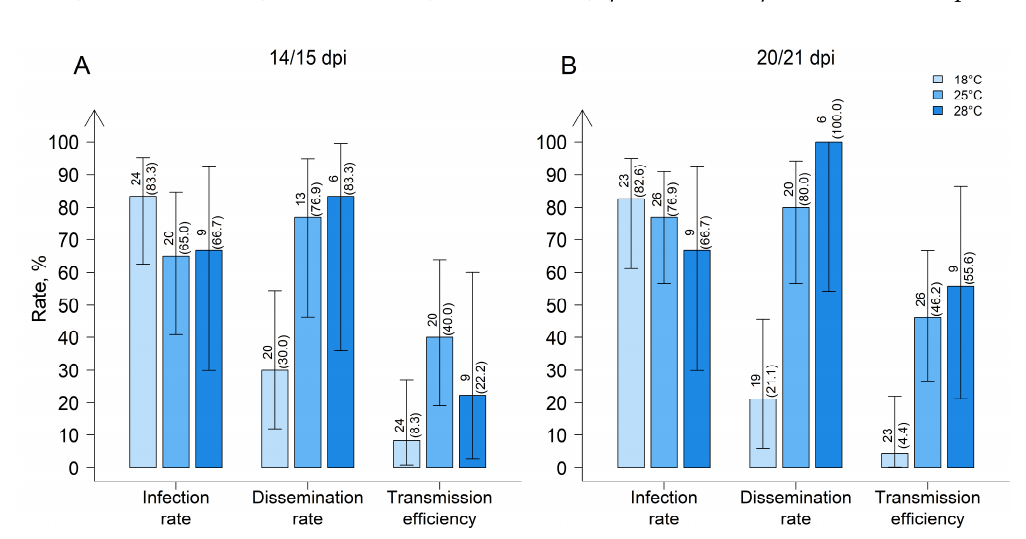
Figure 3. Infection rate, dissemination rate, and transmission e ffi ciency of field-collected Culex pipiens biotype pipiens from “Groß Kreutz”, Brandenburg, Germany, ( A ) 14 / 15 and ( B ) 20 / 21 days post infection (dpi) at three di ff erent temperature regimes. Error bars represent 95% confidence intervals. The number above each bar indicates the number of mosquitoes tested per species / time point, and in brackets, the percentage tested